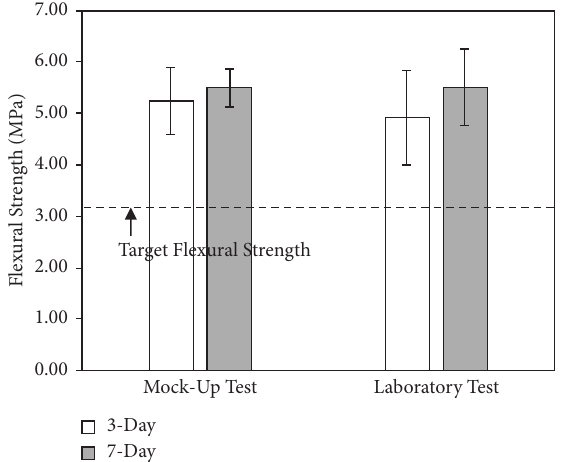
Figure 12: Comparison of flexural strength in mock-up and laboratory tests.